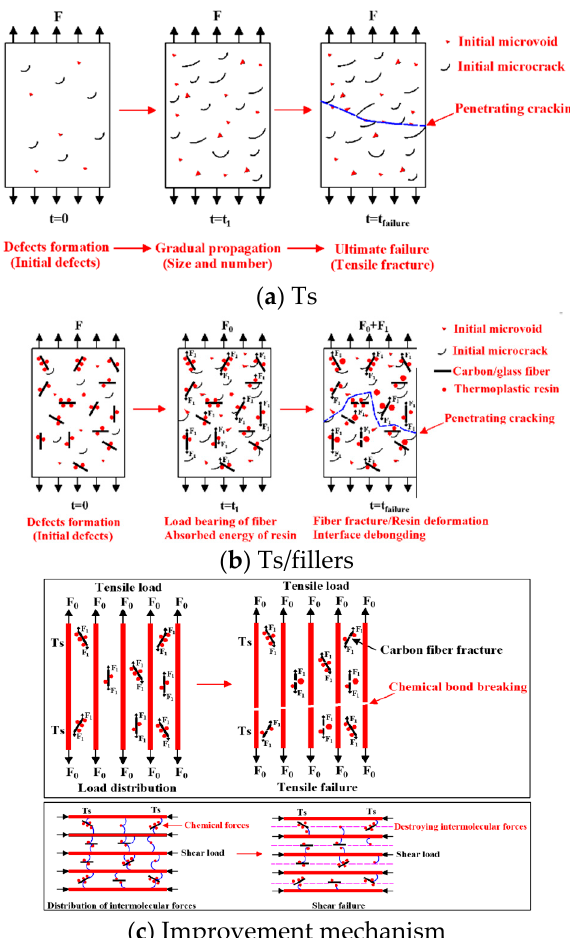
Figure 18. Effects of thermoplastic resin and composite fillers on failure mechanism of Ts resin of ( a ) Ts, ( b ) Ts/fillers and ( c ) improvement mechanism.